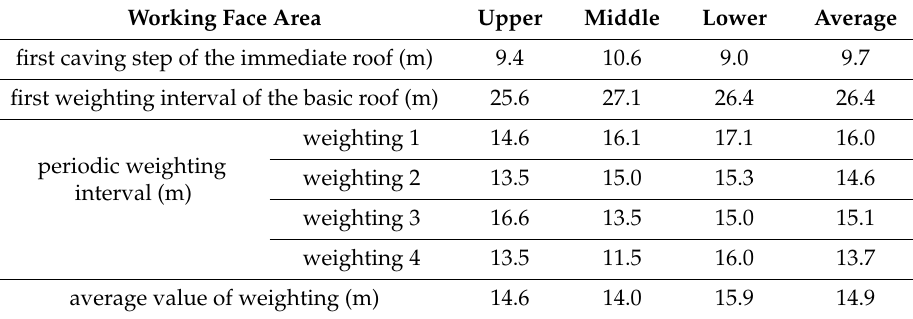
Table 4. Weighting of the 051508 working face